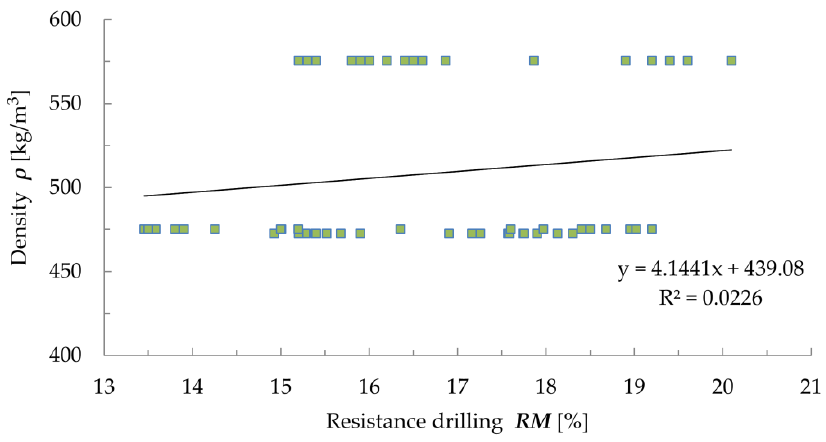
Figure 9. Correlation between drilling resistance and density.